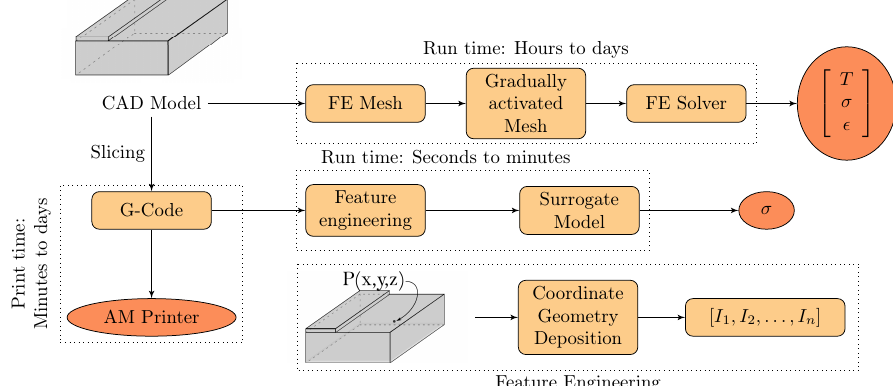
Figure 1: A schematic representation of numerical model, surrogate model, and printing process. In general, it takes a few minutes to hours to print a part depending on the size. Few exceptionally large parts require hours to print. However, it requires hours to days to simulate the same parts using traditional modelling. A surrogate model can predict the output in real-time.